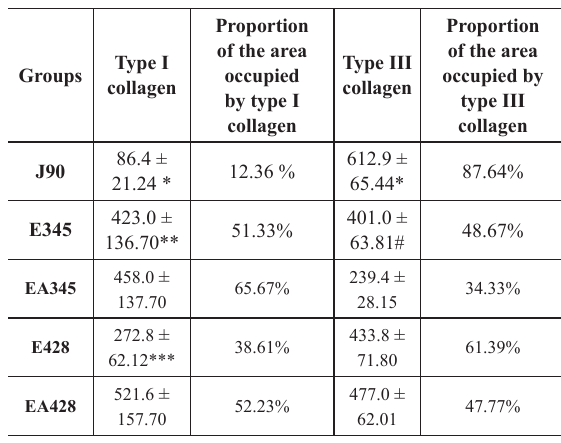
Area occupied (µm 2 ) by the types I and III collagen and its proportion (%) in the periodontal ligament of rats in groups: